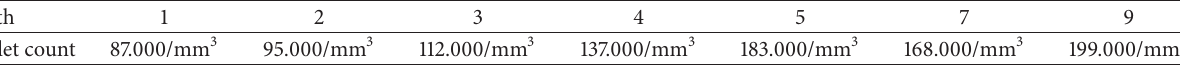
Table 1: Platelet count by months after gluten-free diet.